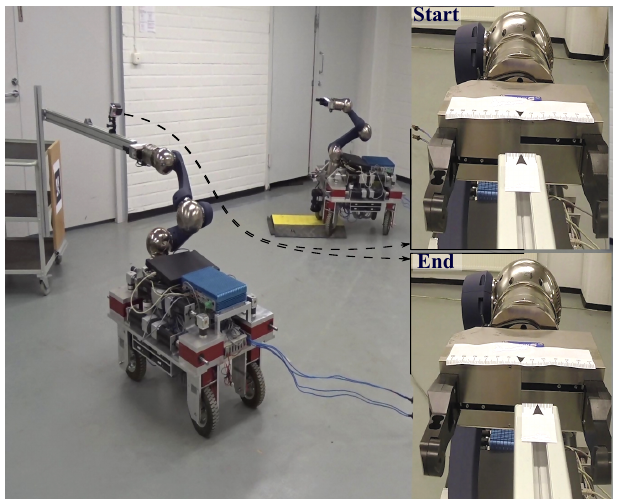
Figure 12. Experiment : The repeatability of the path-following controller. The robot starts from the grasping position marked by ”Start“ follows the path shown in Figure 13 and returns close to the initial pose.